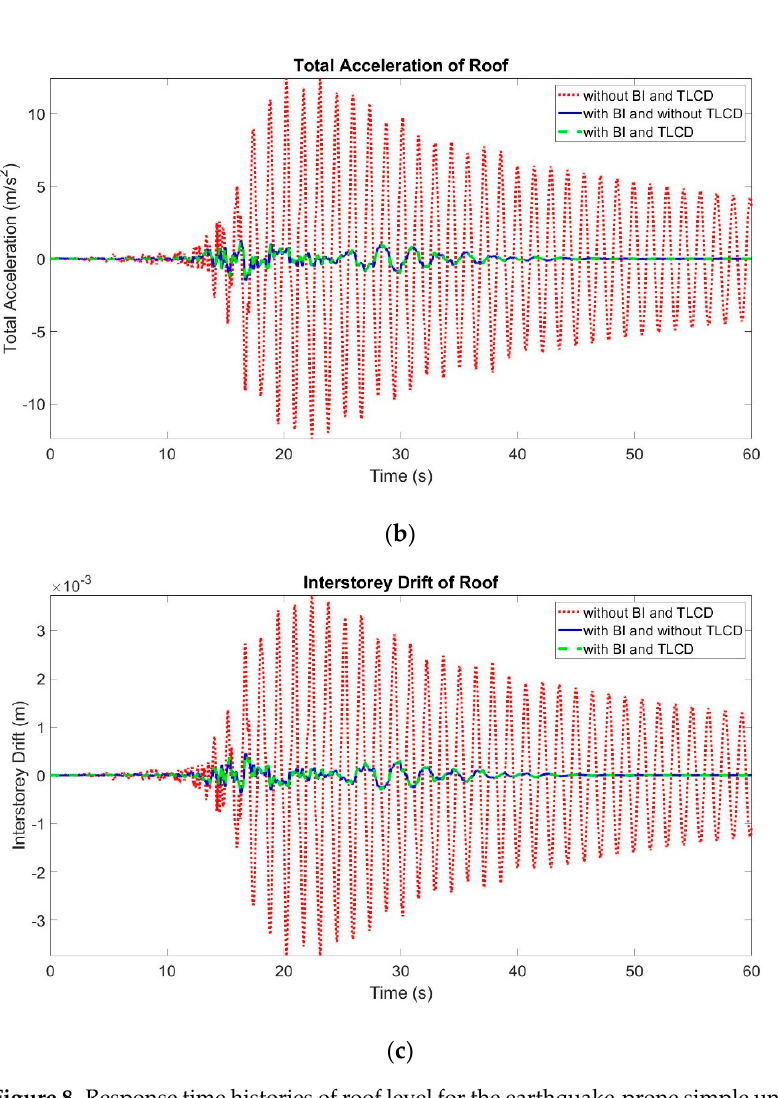
Figure 8. Response time histories of roof level for the earthquake-prone simple uncontrolled structure, base-isolated structure, and hybrid-controlled structure no. 21 record: ( a ) displacement; ( b ) total acceleration; ( c ) interstory drift.